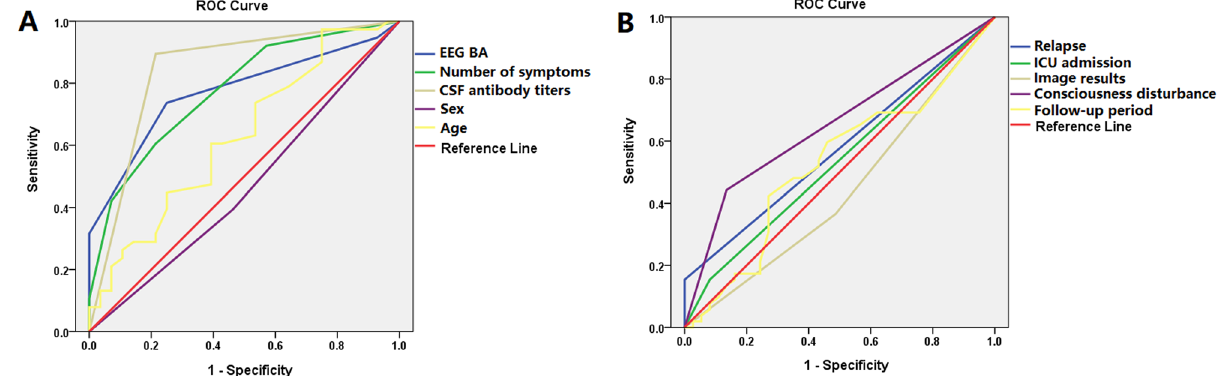
Figure 5. ( A ) The predictors for poor outcomes included EEG BA (area: 76.6%, sensitivity: 73%, specificity: 75%, P = 0.000), number of symptoms (area: 77.1%, sensitivity: 59.5%, specificity: 78.6%, P = 0.000) and CSF antibody titers (area: 83.9%, sensitivity: 89.2%, specificity: 78.6%, P = 0.000) in the ROC curve analysis. ( B ) The consciousness disturbance was related to poor outcomes (area: 65.4%, sensitivity: 44.2%, specificity: 86.5%, P = 0.014, ( B) ), BA background